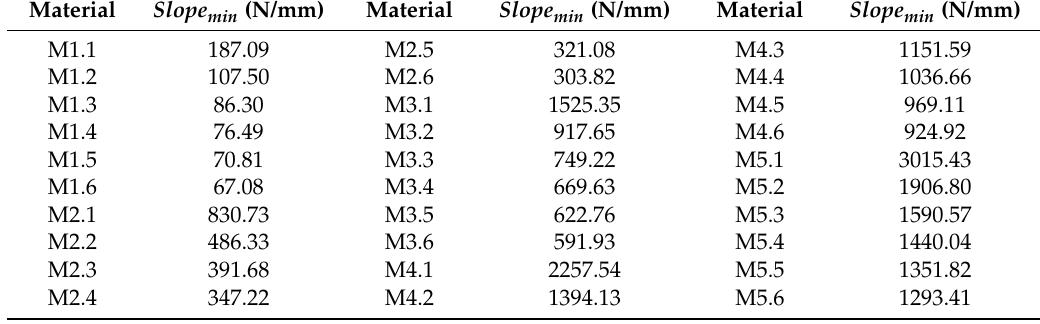
Table 3. Slope min of the SPT curves.